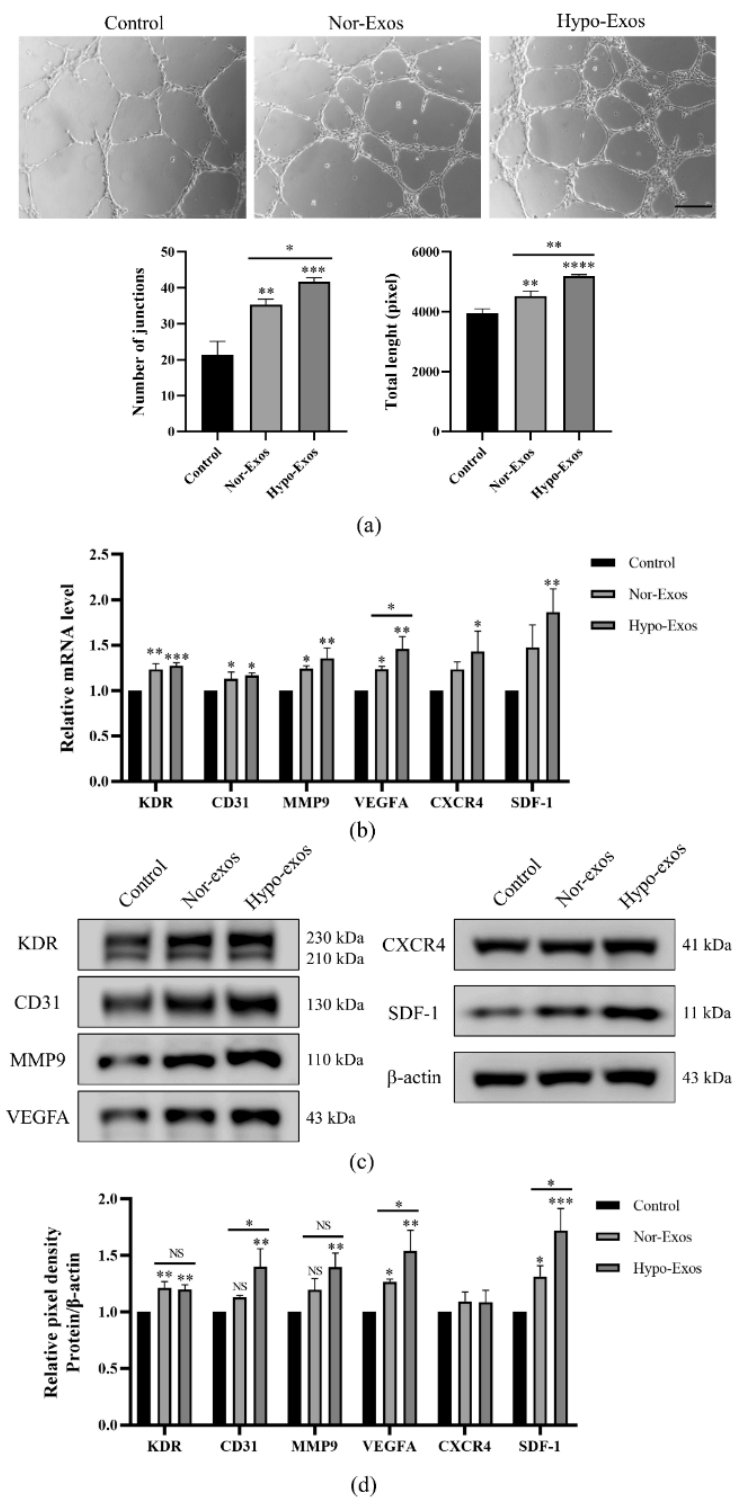
Figure 4. Effects of Nor-Exos and Hypo-Exos (10 µ g/mL) on HUVECs in vitro angiogenesis. ( a ) In vitro tube formation of HUVECs. ( b ) The mRNA levels of angiogenesis-associated factors in HUVECs were detected by quantitative real-time PCR. ( c ) The protein levels of angiogenesis-associated factors in HUVECs were detected by Western blot analysis. ( d ) Quantitative analysis of the relative protein expression in ( c ). n = 3, mean ± SD, * p < 0.05, ** p < 0.01, *** p < 0.001, **** p < 0.0001. NS: no significance. Scale bars: 200 μ m ( a ).